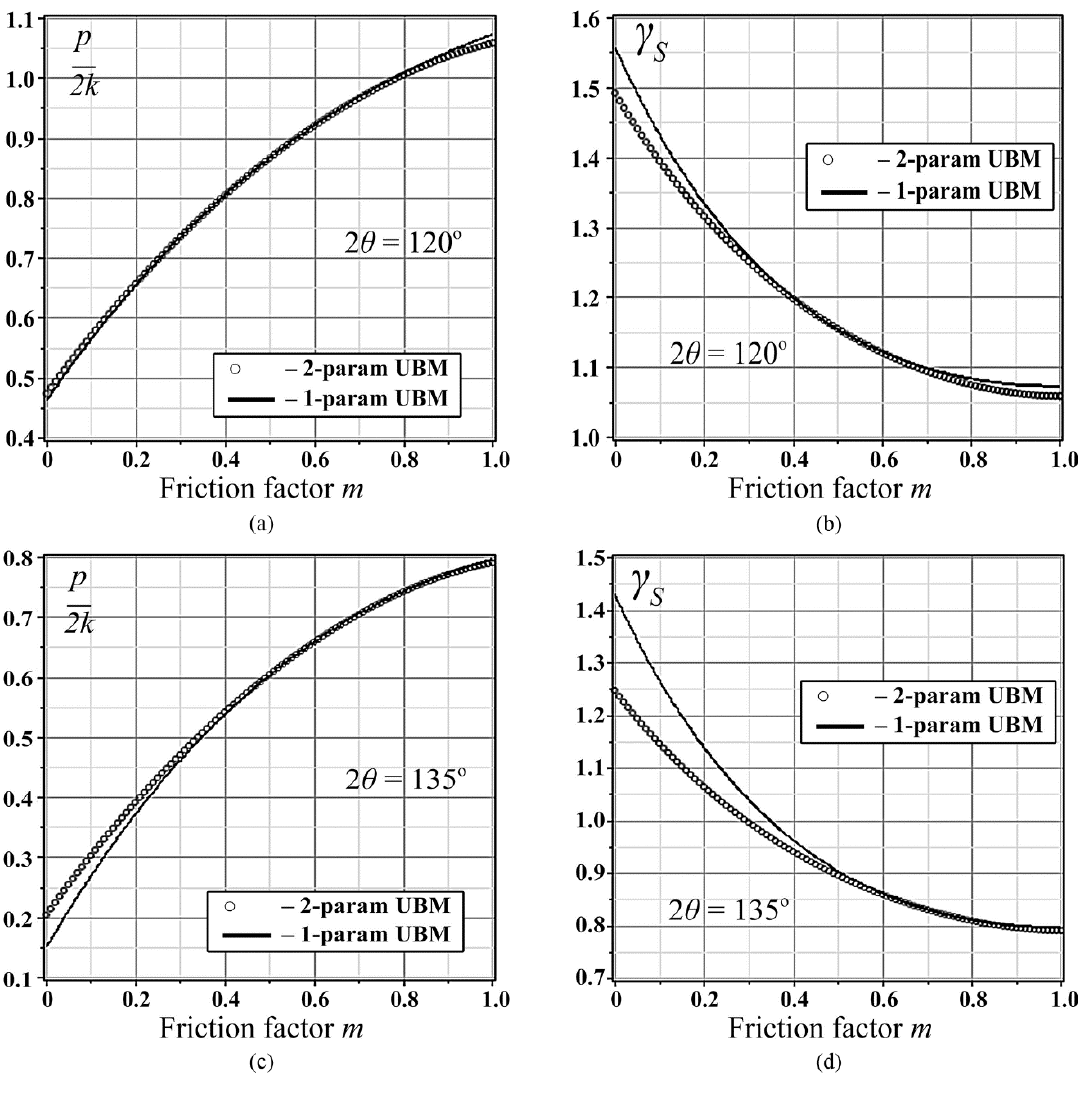
( b , d ) with respect to friction S